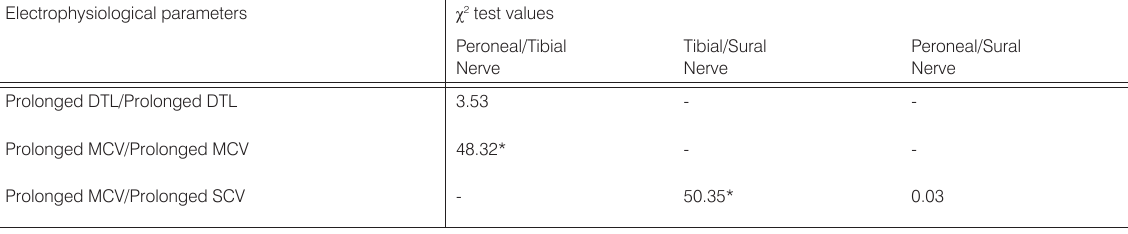
Table 3. Differences in frequencies of patients with prolonged evaluated electrophysiological parameters Electrophysiological parameters